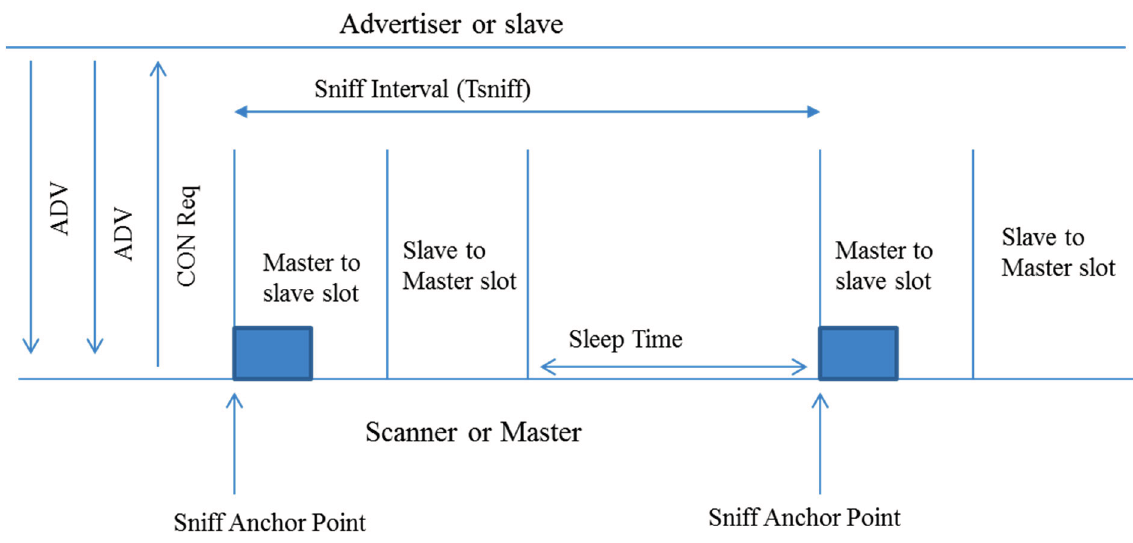
Figure 6. An illustration of Bluetooth Low Energy (BLE) Sniff